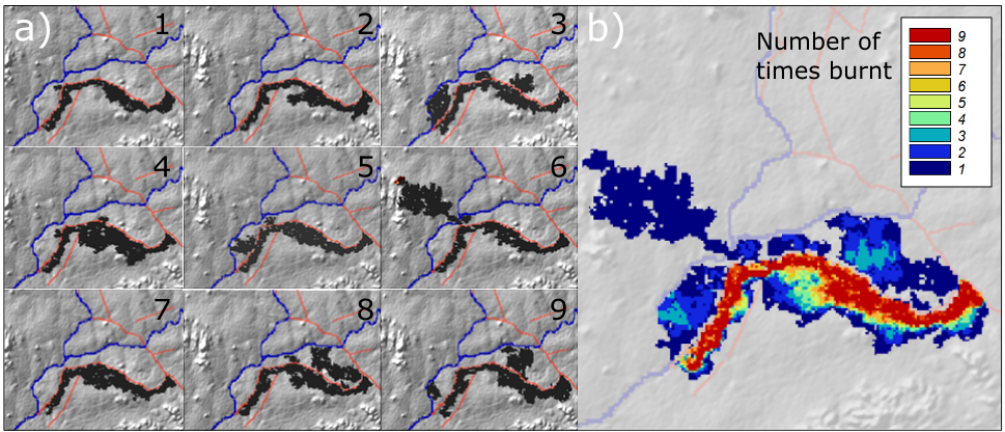
Figure 5. Nine model runs with the same fire weather conditions showing each model run ( a ) and the number of times “burnt” ( b